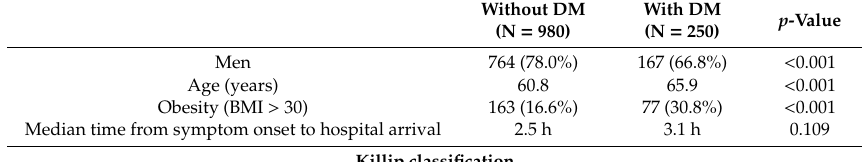
Table 1. Baseline characteristics of the PRAGUE 18 study population relative to diabetes mellitus